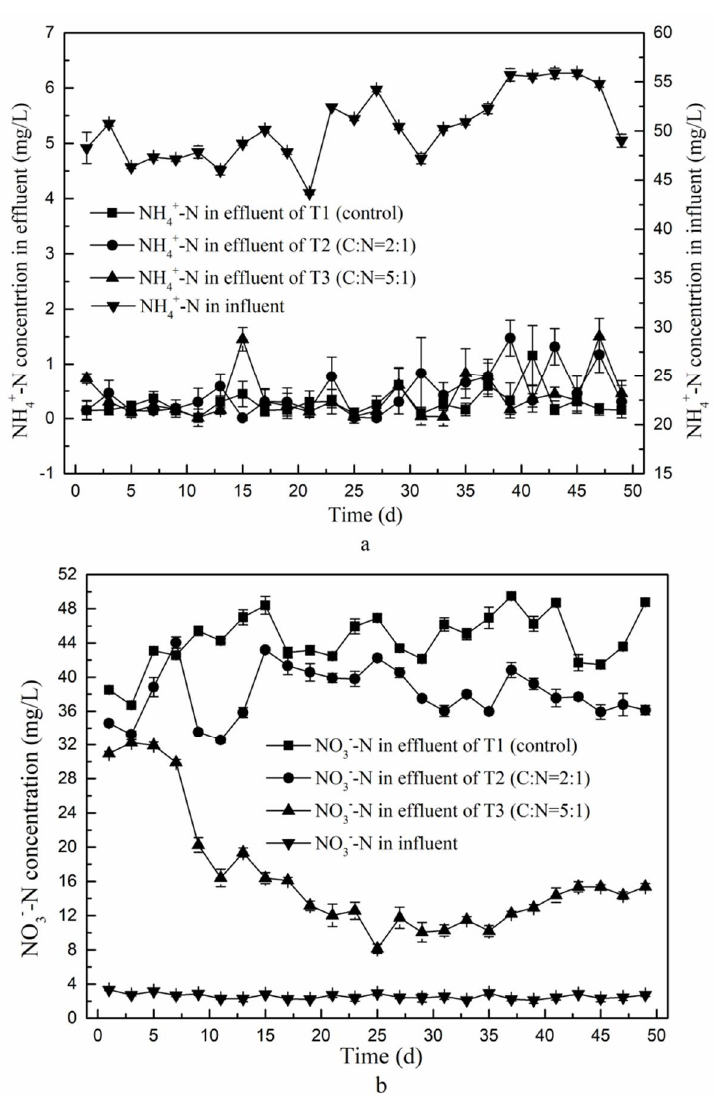
Figure 4. Overall ammonium and nitrate concentrations of a modeled two-stage CRI over time. ( a ) Absolute concentrations of NH 4+ -N in first-stage influent and in the second-stage effluent of the three experimental setups; ( b ) The nitrate concentration in influent of the first stage and in the effluent of the second stage in the three experimental setups.